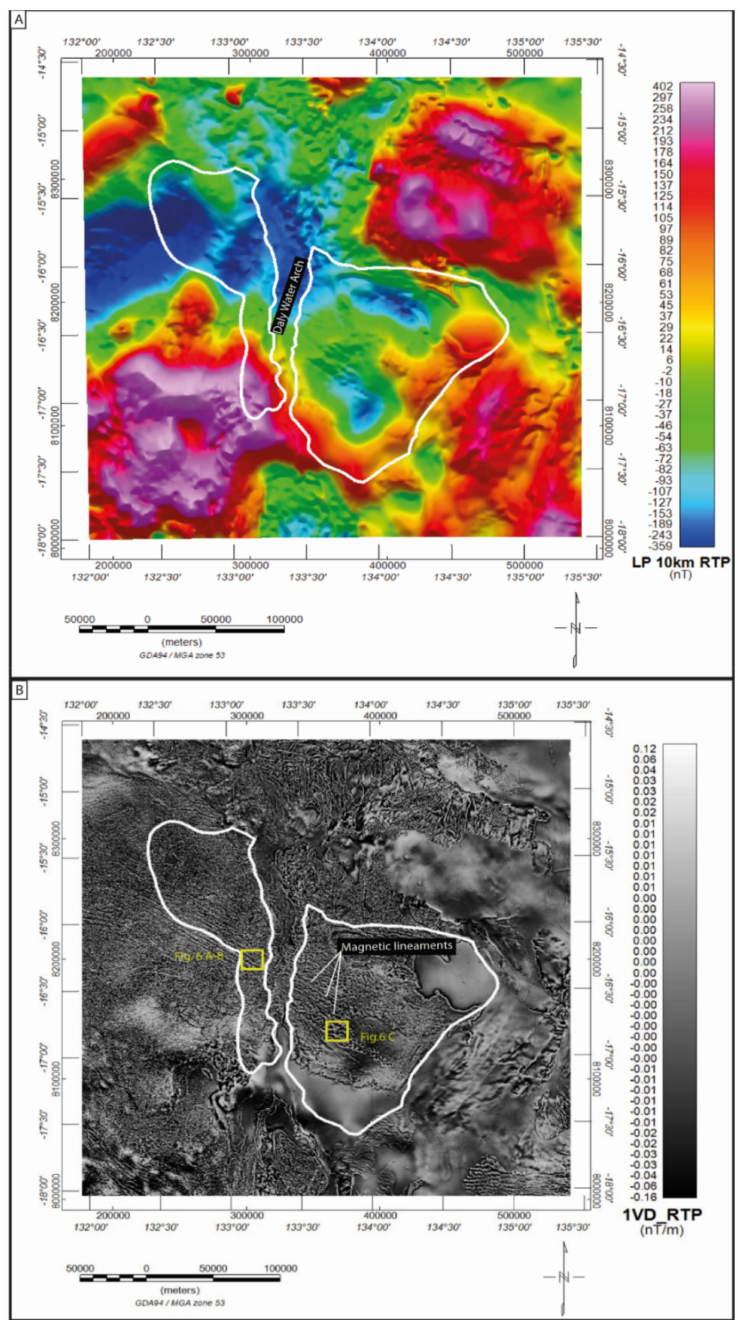
Figure 3. ( A ) Low pass reduced-to-pole map of the Beetaloo Sub-basin. The image is presented in a histogram equalised colour scale with shaded relief illuminated from the NE. The Sub-basin outline is in white. ( B ) The first vertical derivative of the reduced-to-pole data. The image is presented in a histogram equalised grey scale with shaded relief illuminated from the NE. The basin outline is in